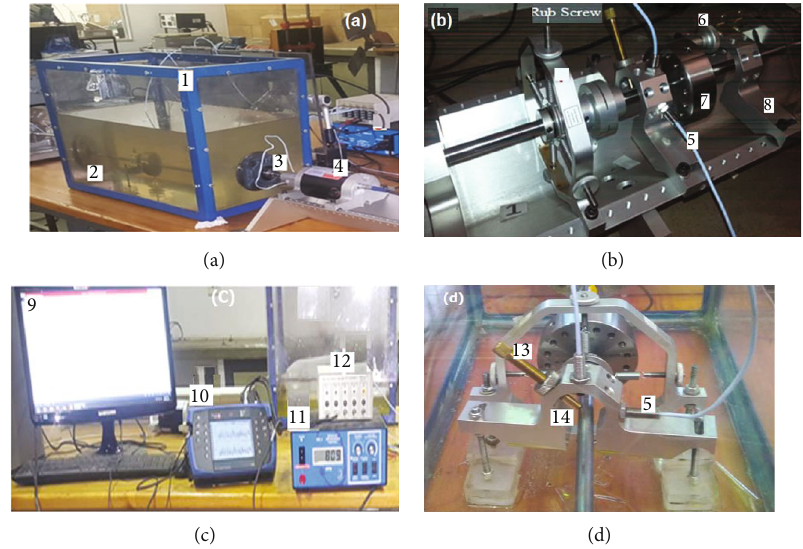
Figure 7: The experimental setup, rub screw setup, and data acquisition system.: 1 — tank, 2 — water, 3 — fl exible coupling, 4 — motor, 5 — probes, 6 — mass unbalance, 7 — disc, 8 — rub housing, 9 — computer screen, 10 — scout-2013, 11 — motor speed controller, 12 — junction box, 13 — rub screw, and 14 — rotor-stator